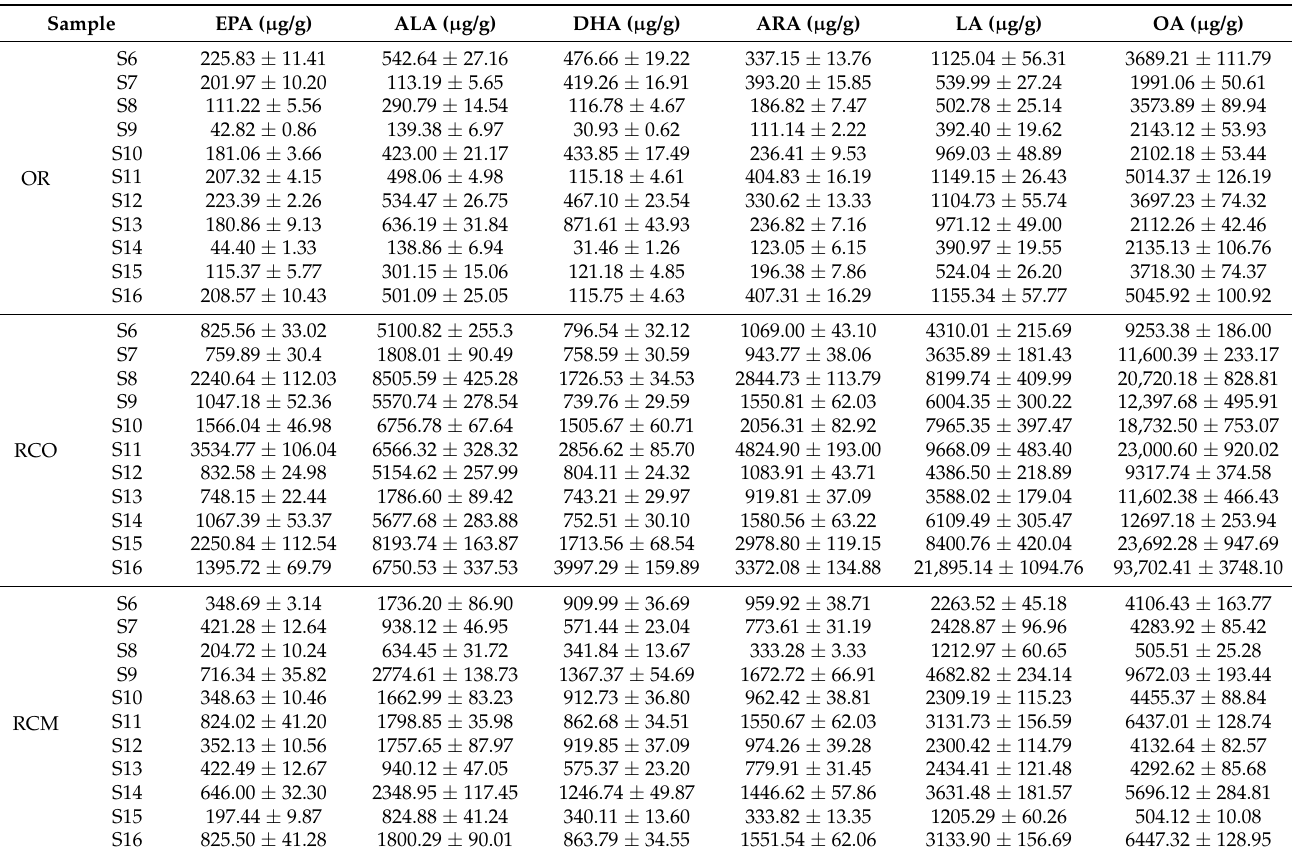
Figure 6. The HPLC chromatogram of mixed standard of six PUFAs, OR, RCO, RCM, RCS, and RCB. (1. ALA; 2. ALA; 3. DHA; 4. ARA; 5. LA; 6. OA). Table 5. The contents of PUFAs in Different Tissue of Rana chensinensis samples. (X ±